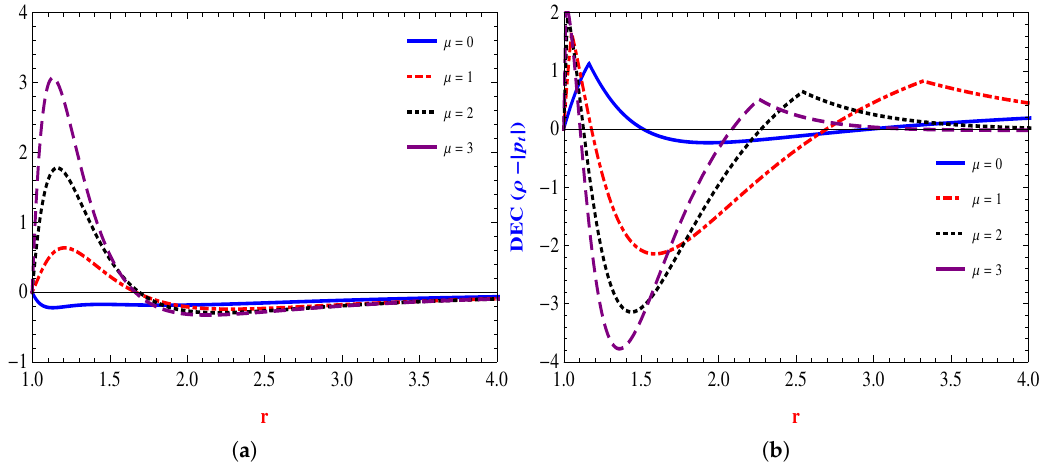
Figure 6. Plots: ( a ) Radial DEC ( ρ − | p r | ) , and ( b ) Tangential DEC ( ρ − | p t | ) with throat radius r 0 = 1, α = 1, and β = 2 in f ( Q ) = α Q 2 + β gravity.